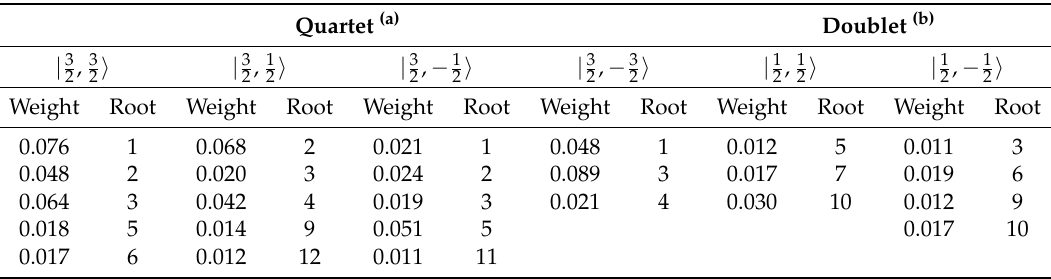
Table 3. One of the Kramers pair wave functions of U(MeBTP) 3 + wave function, with 14 quartet and 25 doublet states. The second state can be inferred, via Kramers degeneracy, exchanging the weights of each + M S state with that of the corresponding − M S state. States with weight less than 0.01 are